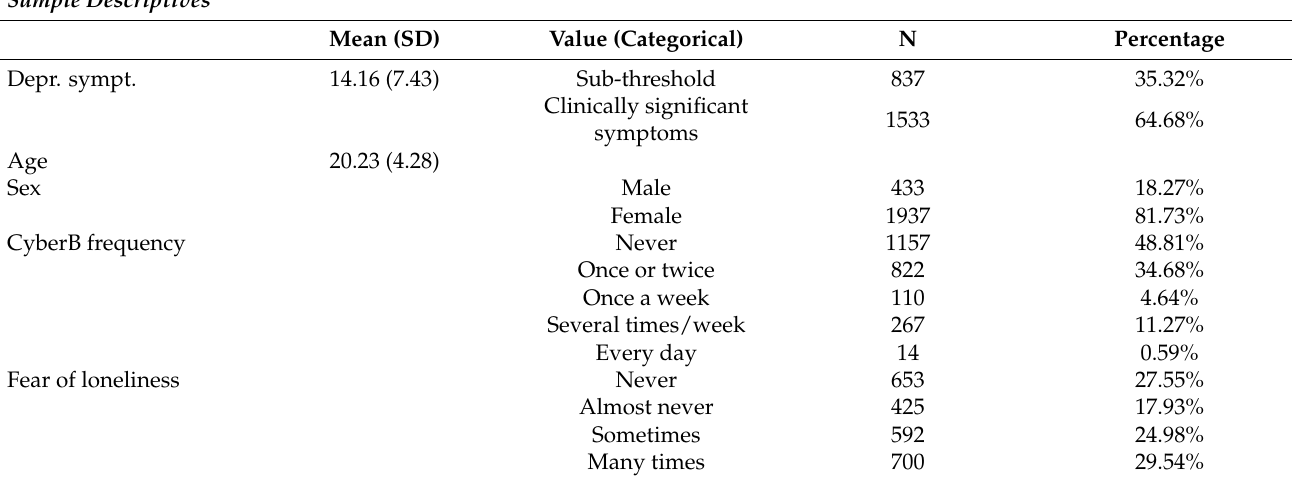
Table 1. Descriptive statistics.